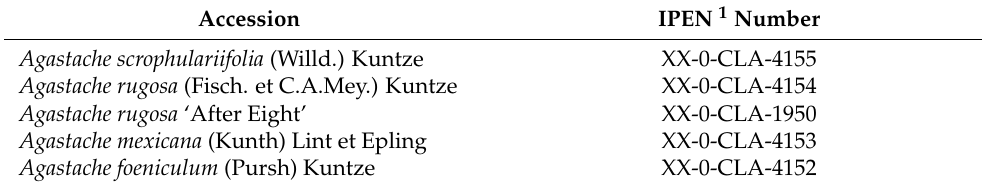
Table 2. Agastache sp. accessions.